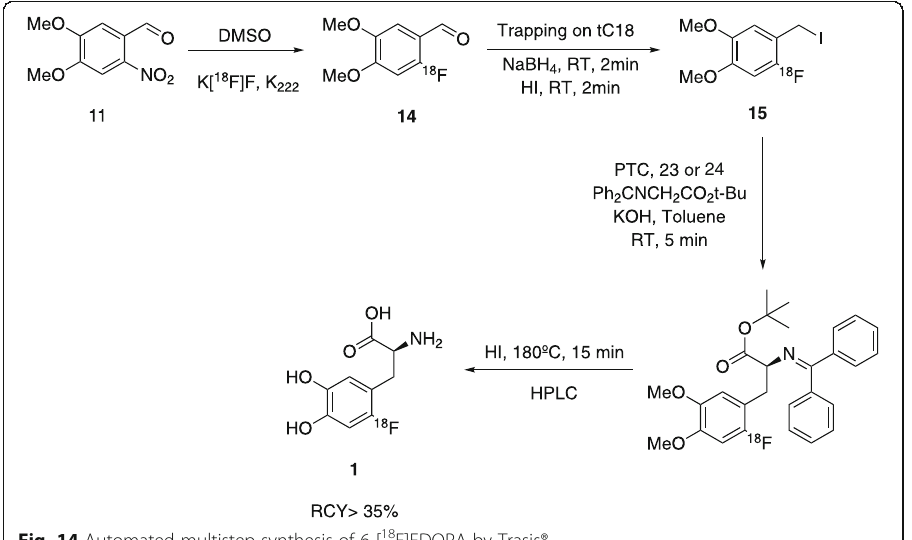
Fig. 14 Automated multistep synthesis of 6-[ 18 F]FDOPA by